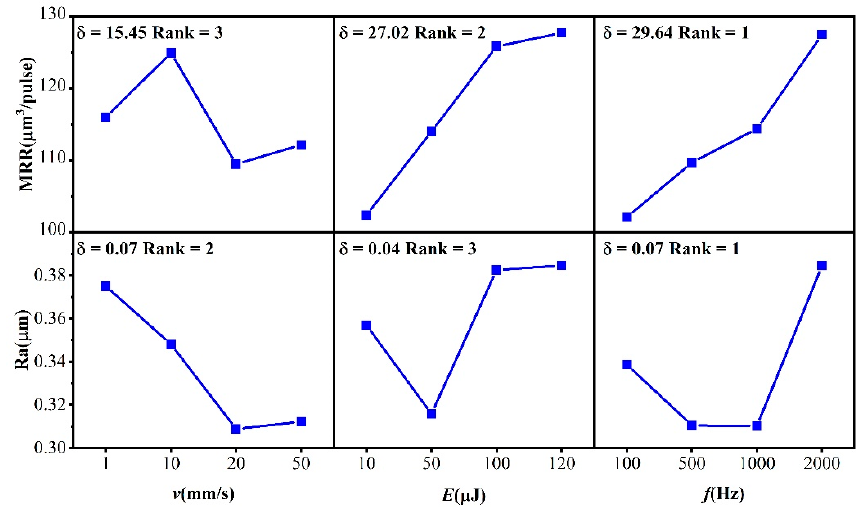
Figure 13. Responses for the S/N of Ra and MRR measurements. The significant rank in the MRR response is f > E > v , the Ra response ratio follows f > v > E .